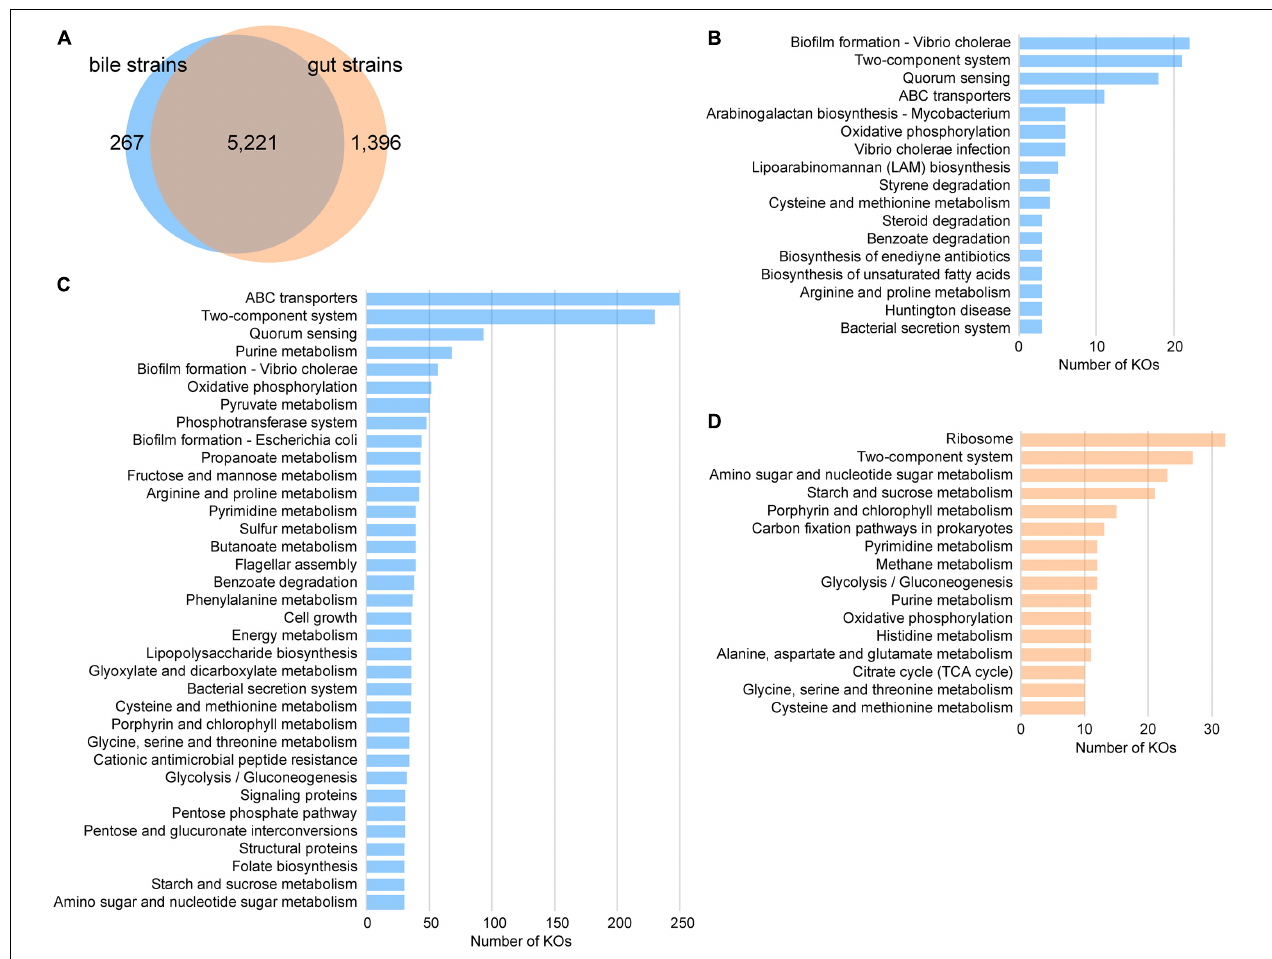
FIGURE 3 | Comparison of the functions of bile and gut bacterial strains. (A) Venn diagram shows the comparison of KEGG orthologs (KOs) between bile and gut strains. (B–D) Distribution of KEGG level C pathways of the bile-specific KOs (B) , the bile-enriched KOs (C) , and the gut-enriched KOs (D) .